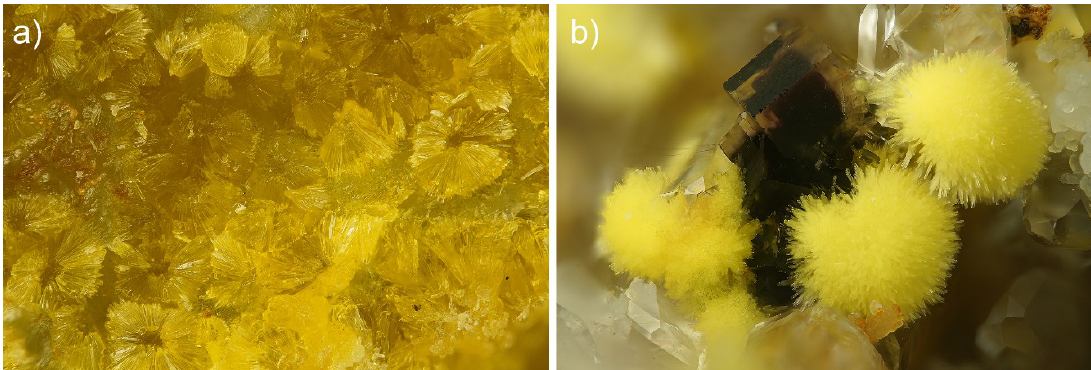
Figure 5. ( a ) Crystalline crust composed of weeksite long prismatic crystals on a specimen from the Anderson mine (Yavapai County, Utah, USA). Horizontal FOV is 3 mm (photo S. Wolfsried). ( b ) Long-prismatic fine crystals of haiweeite associated with quartz (colorless) and fluorite (dark) on a specimen from Teófilo Otoni (Mucuri valley, Minas Gerais, Brazil). Horizontal FOV is 4 mm (photo S. Wolfsried).